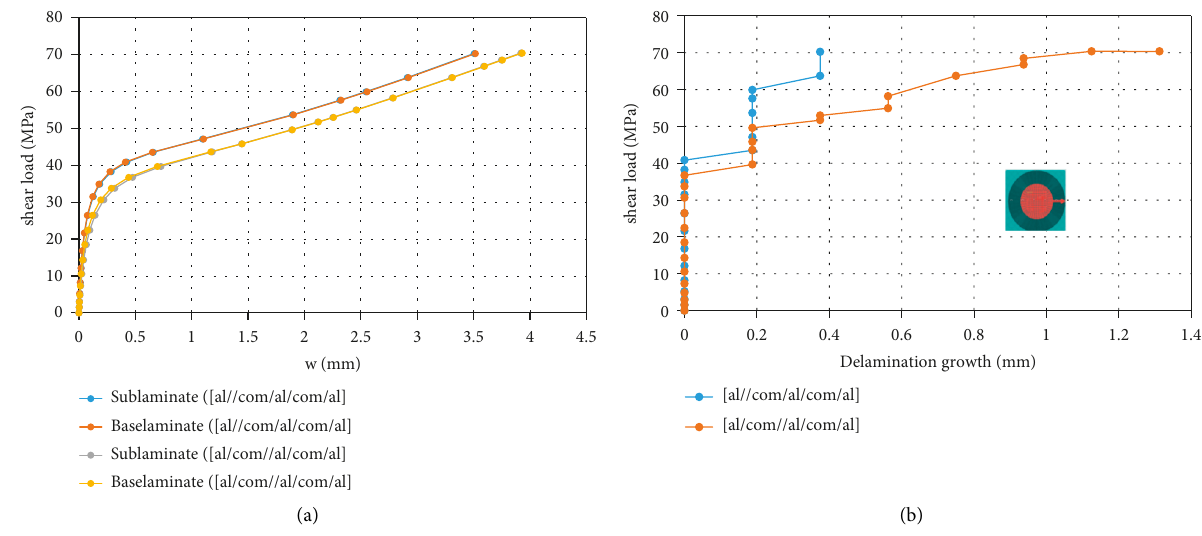
Figure 12: (a) Postbuckling behaviour of GALRE 3 3/2 0.5 and (b) delamination growth of GALRE 3 3/2 0.5.